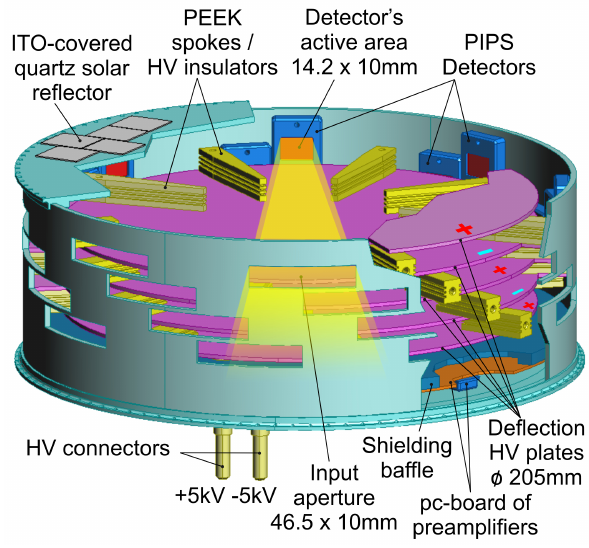
Fig. 2. Exploded 3-D-view of the NUADU Sensor